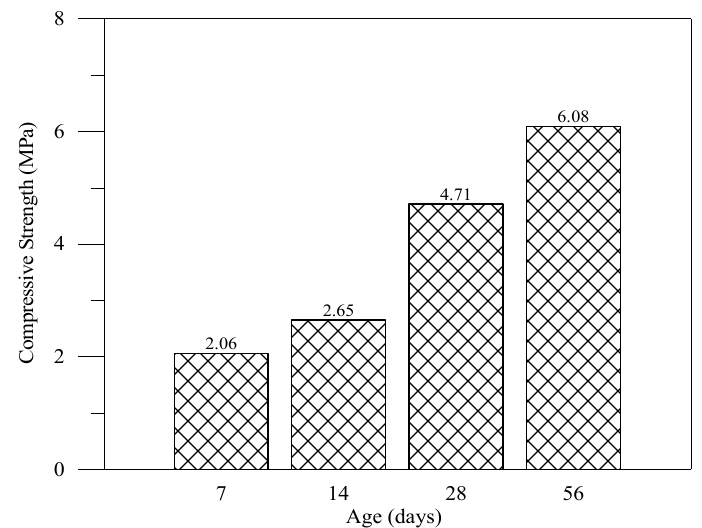
Figure 3. Compressive strength histograms.